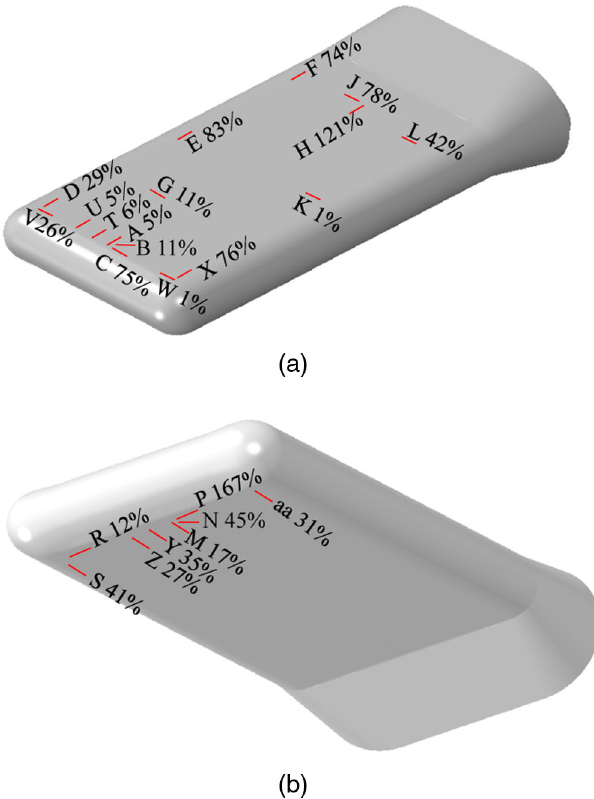
FIG. 19. Strain range value comparison at the sensor locations: top view (a) and bottom view